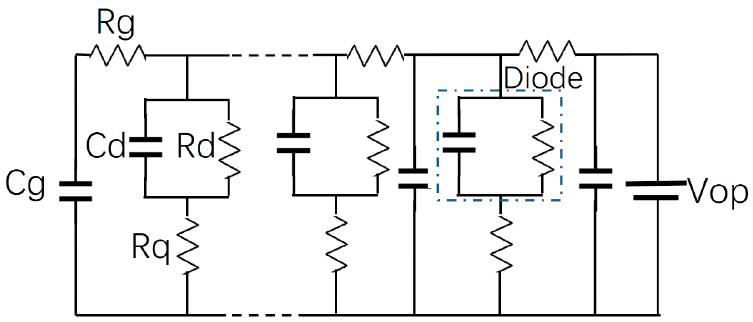
Figure 6. Equivalent electrical mode of EQR-SiPM; The diode section consists of the P/N junction( P++ layer and N-enrich region), R q is the quenching resistance, which consists of epitaxial resistor, Rg is the resistance produced by the P++ layer and Cg is the capacitance produced by the Gap